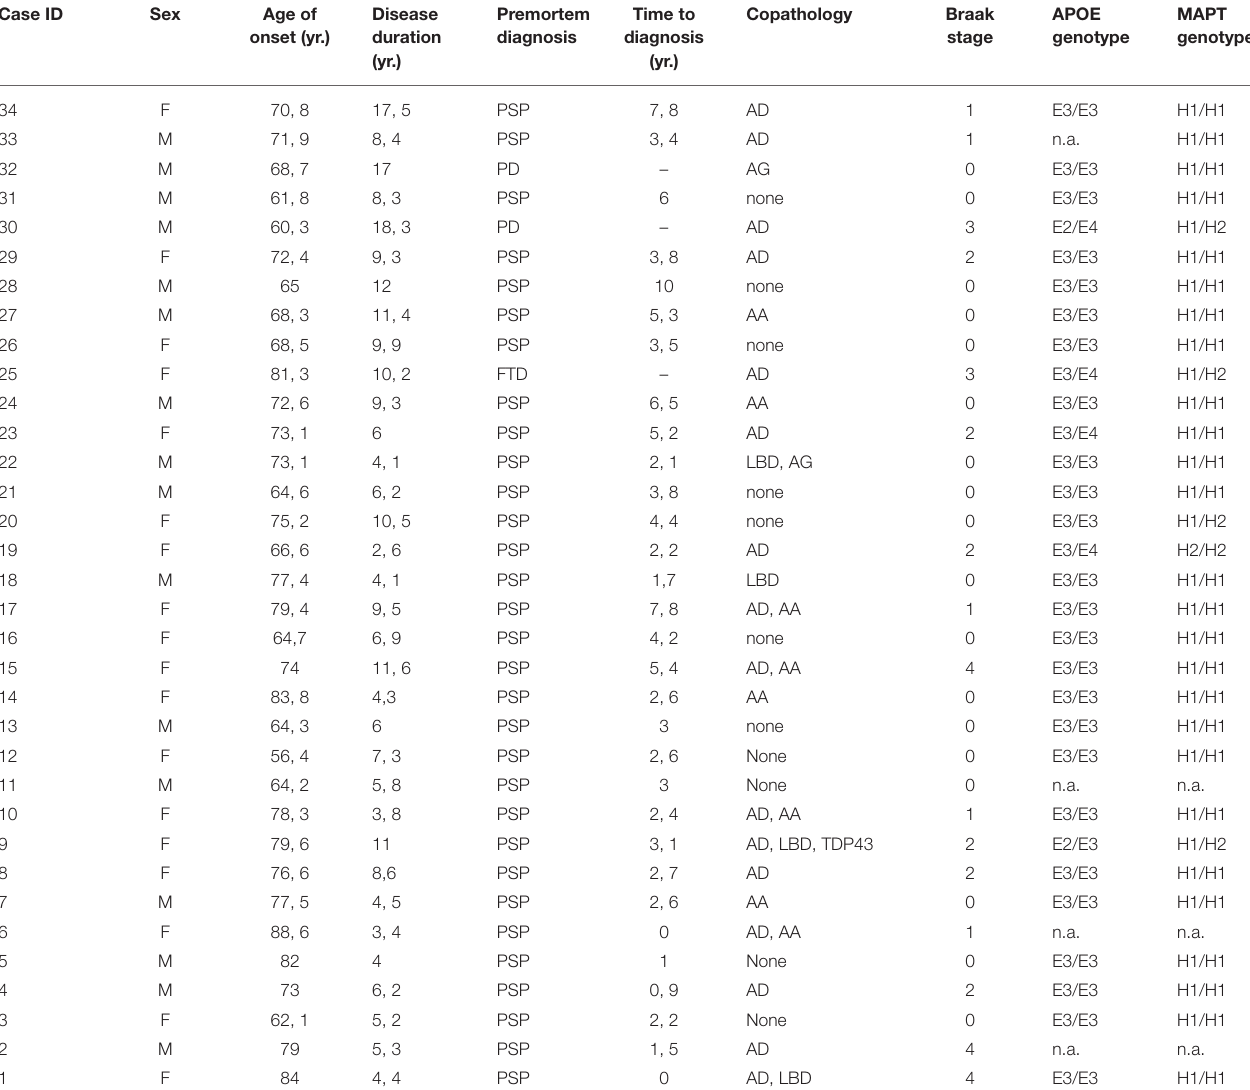
TABLE 1 | Demographic and pathological features of the sample. Case ID Age of